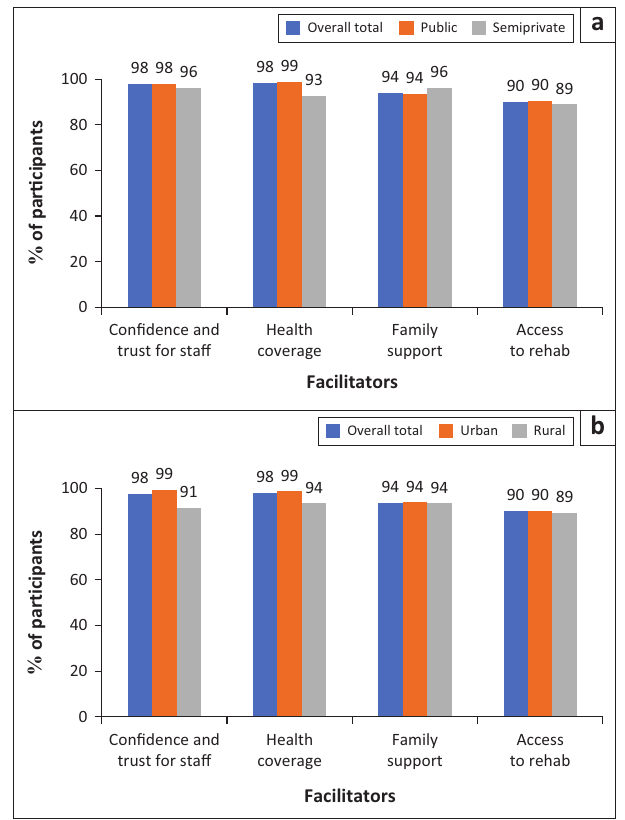
FIGURE 2: (a) Facilitators to rehabilitation use facility funding source where participants were recruited (public: n = 186; semiprivate: n : 27; (b) Facilitators to rehabilitation use by participants’ residence (urban: n = 166, rural: n =